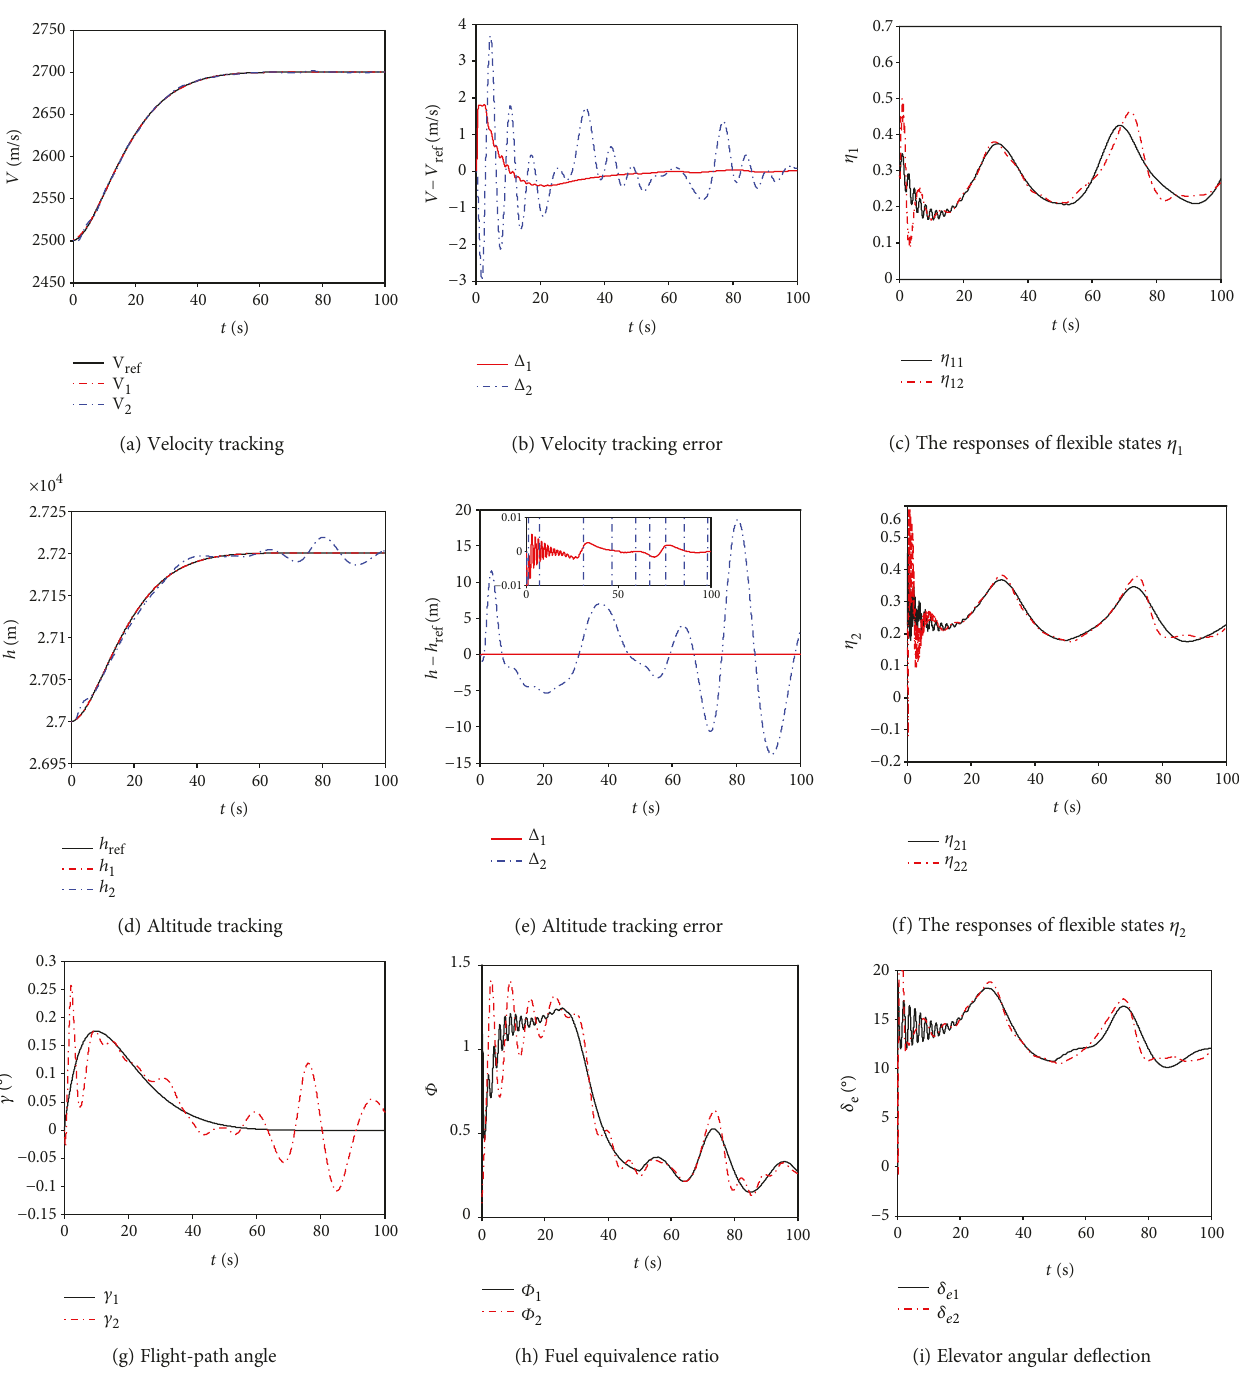
Figure 2: Simulation result of Case